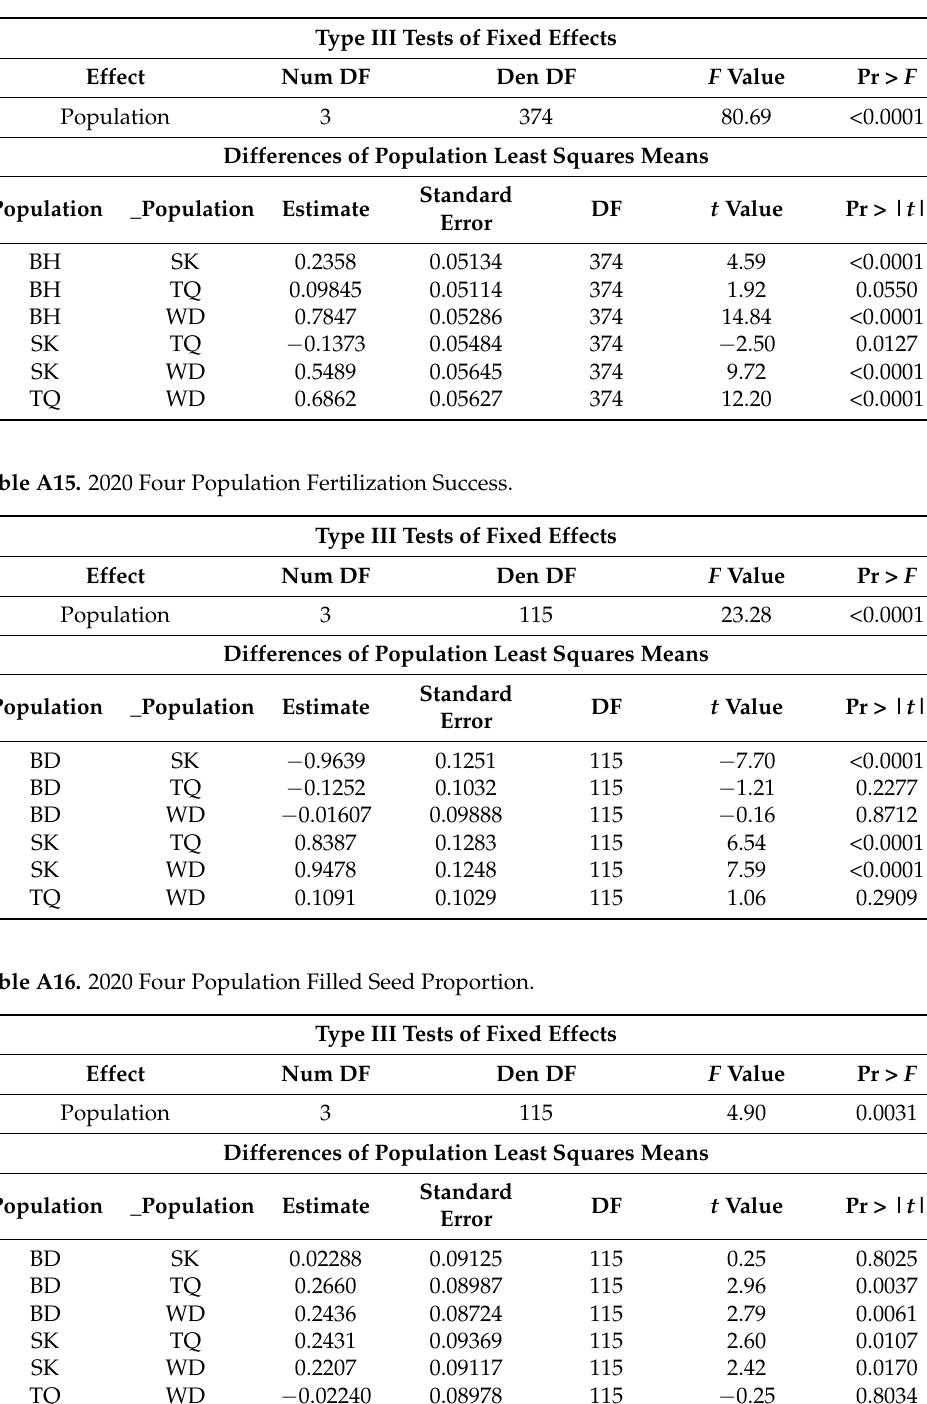
Table A14. 2019 Four Population Filled Seed Proportion.